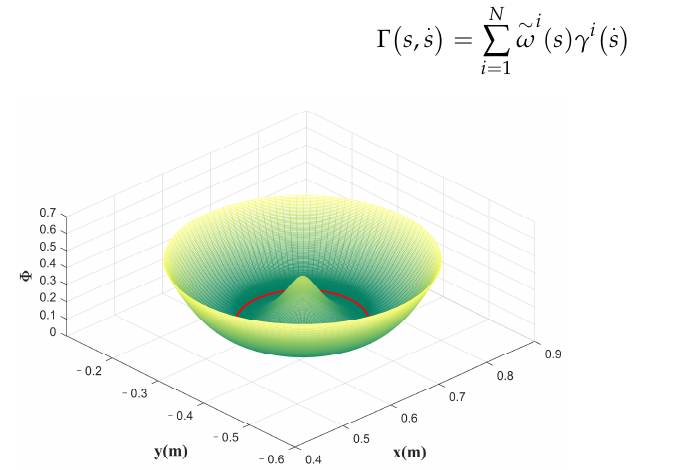
Figure 4. The potential energy field is designed by using a circle as the desired trajectory; the red line is the desired trajectory. The higher the potential energy at the current point, the greater the normal force provided.